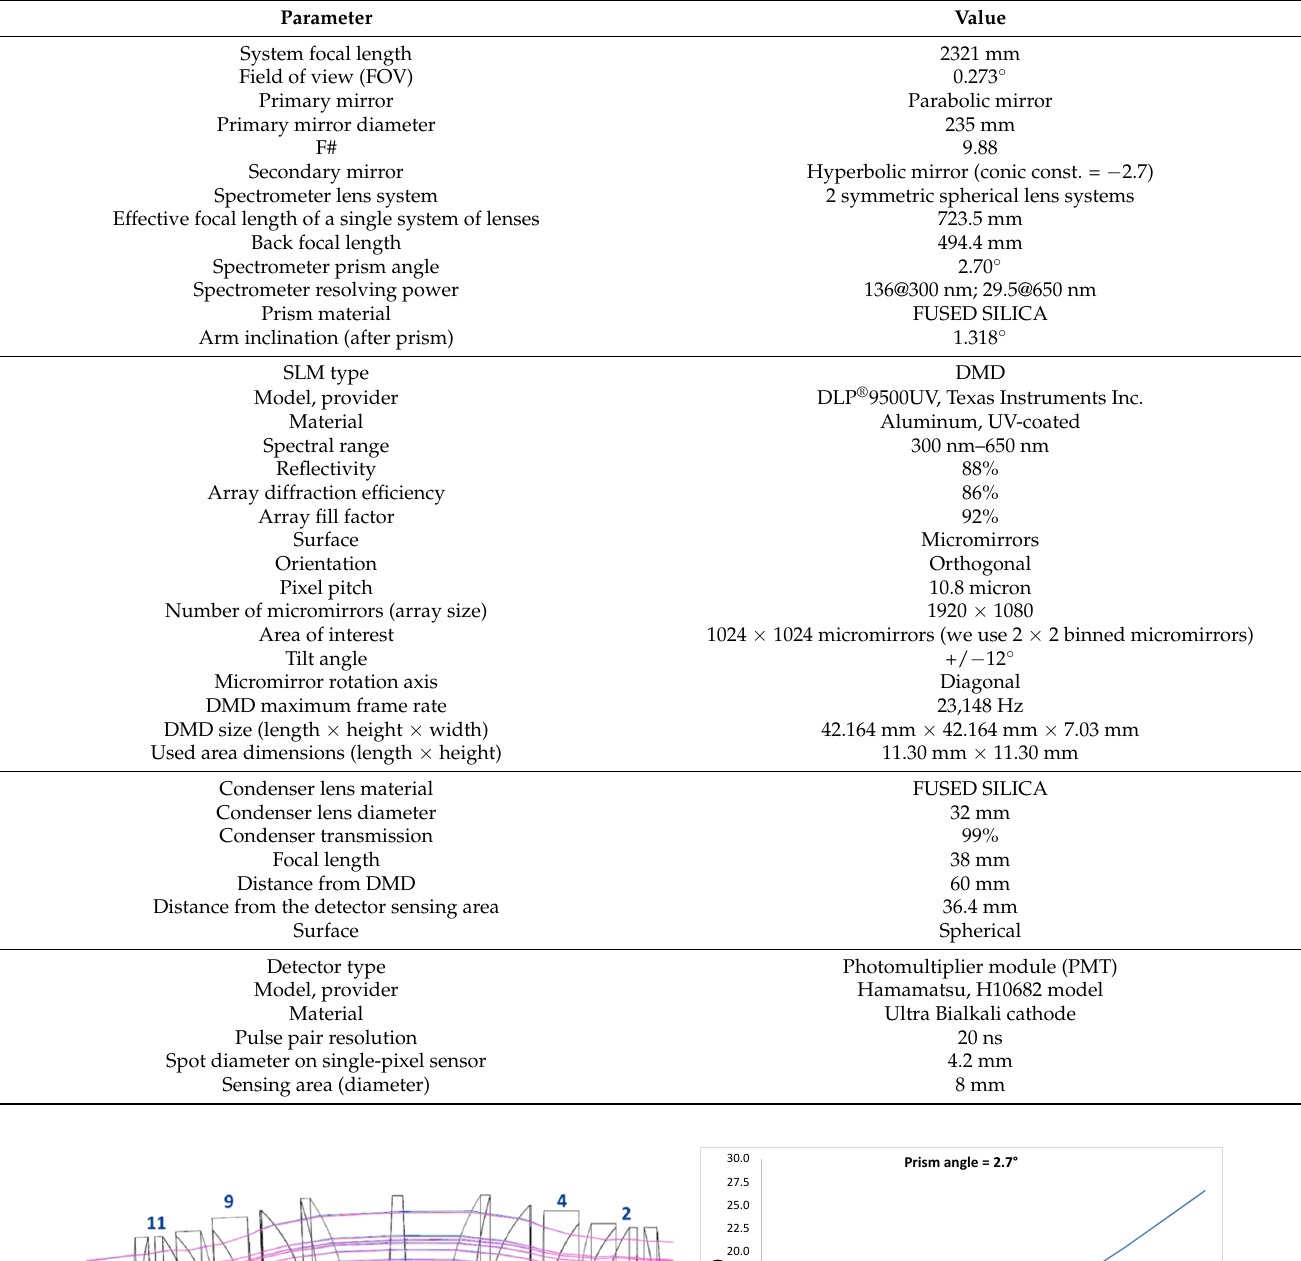
Table 2. Optical design of the instrument: optical components and relevant materials.